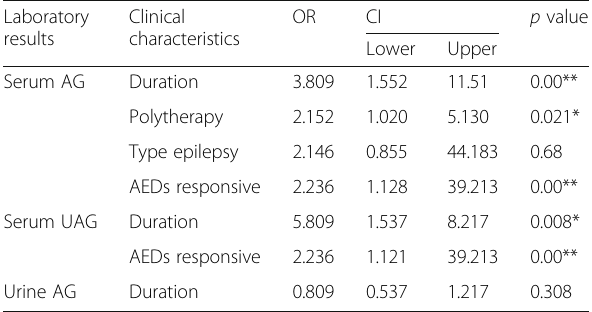
Table 6 Logistic regression analysis between high laboratory parameters and clinical characteristics Laboratory Clinical results